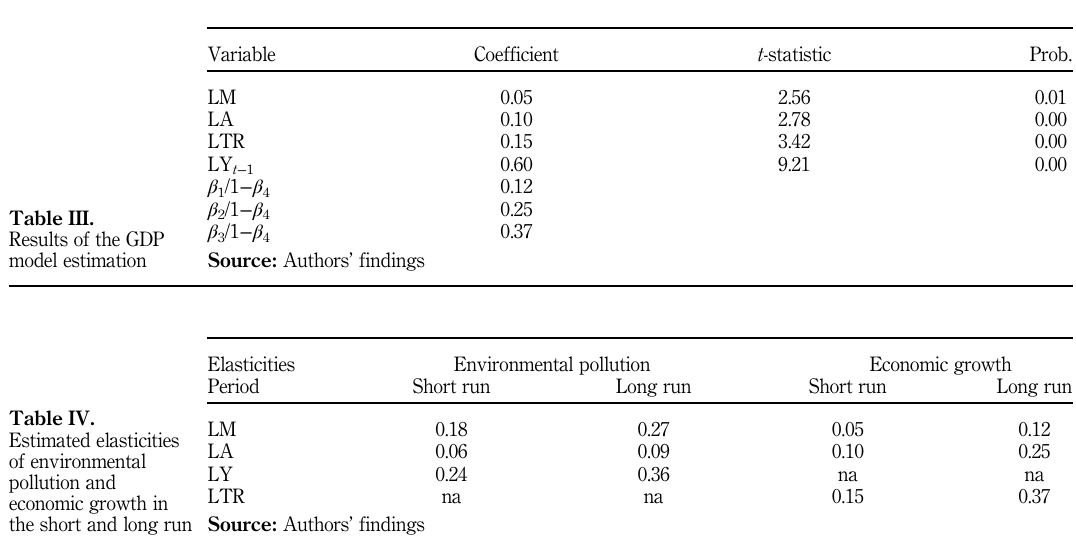
Table II. Results of the CO 2 model estimation